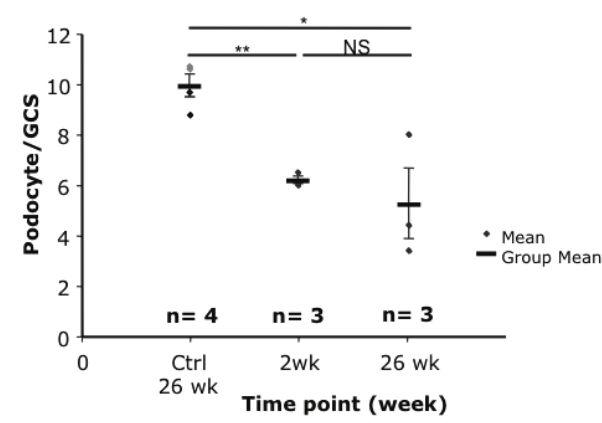
Figure 4. Podocyte quantification of Podo-DTR line 47 mice at 2 and 26 weeks after diphtheria toxin (DT) injection at 1ng/g bw. Podocyte numbers were significantly reduced at 2 and 26 weeks after toxin injection compared to the controls (6.2 and 5.3 versus 10.0 podocyte/GCS respectively, p<0.02). bw, body weight; GCS, glomerular cross section; * p=0.015; ** p=0.001; ♦ , wild-type control mice injected with DT; ♦ , transgenic mice injected with saline.